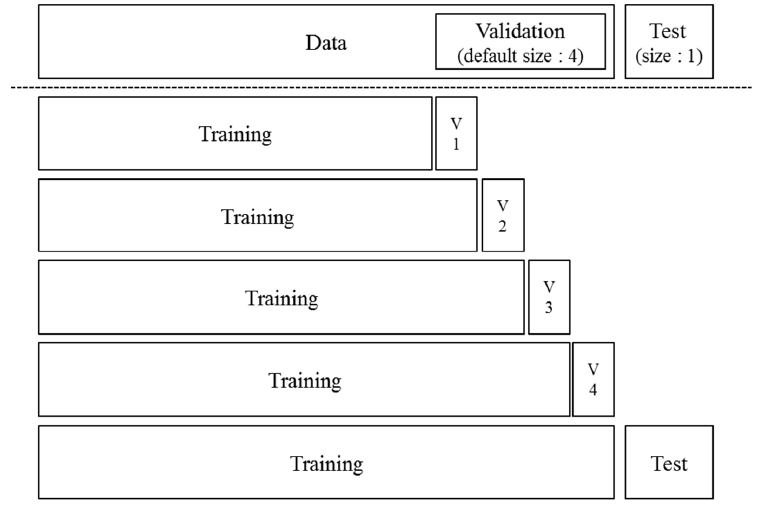
Figure 4. Training, validation, and test set structure.